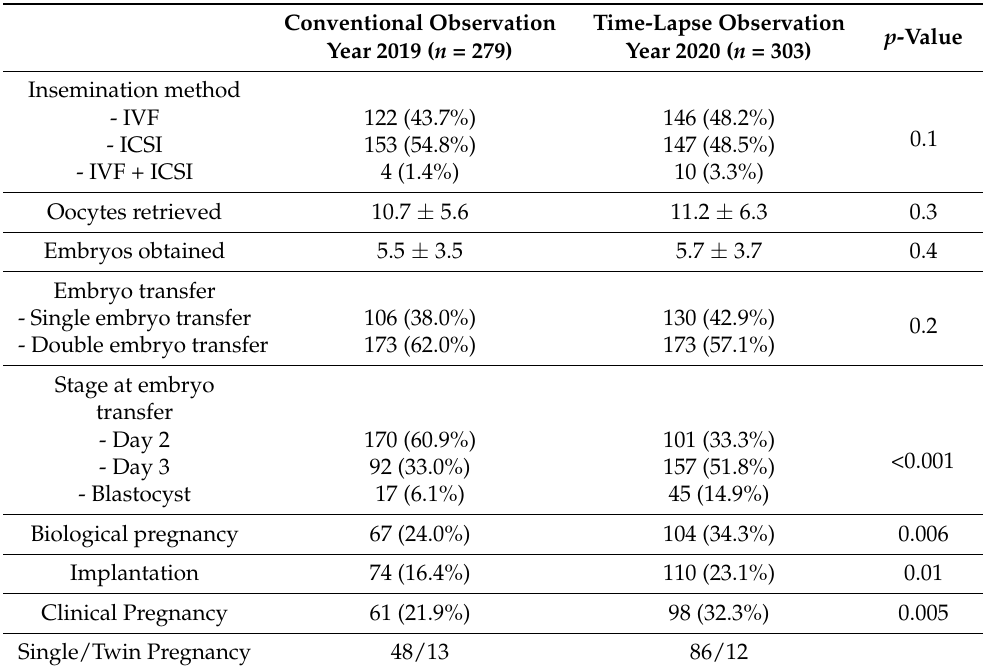
Table 4. IVF cycle characteristics and reproductive outcomes according to the embryo selection method. Values are shown as mean ± SD or n (%).